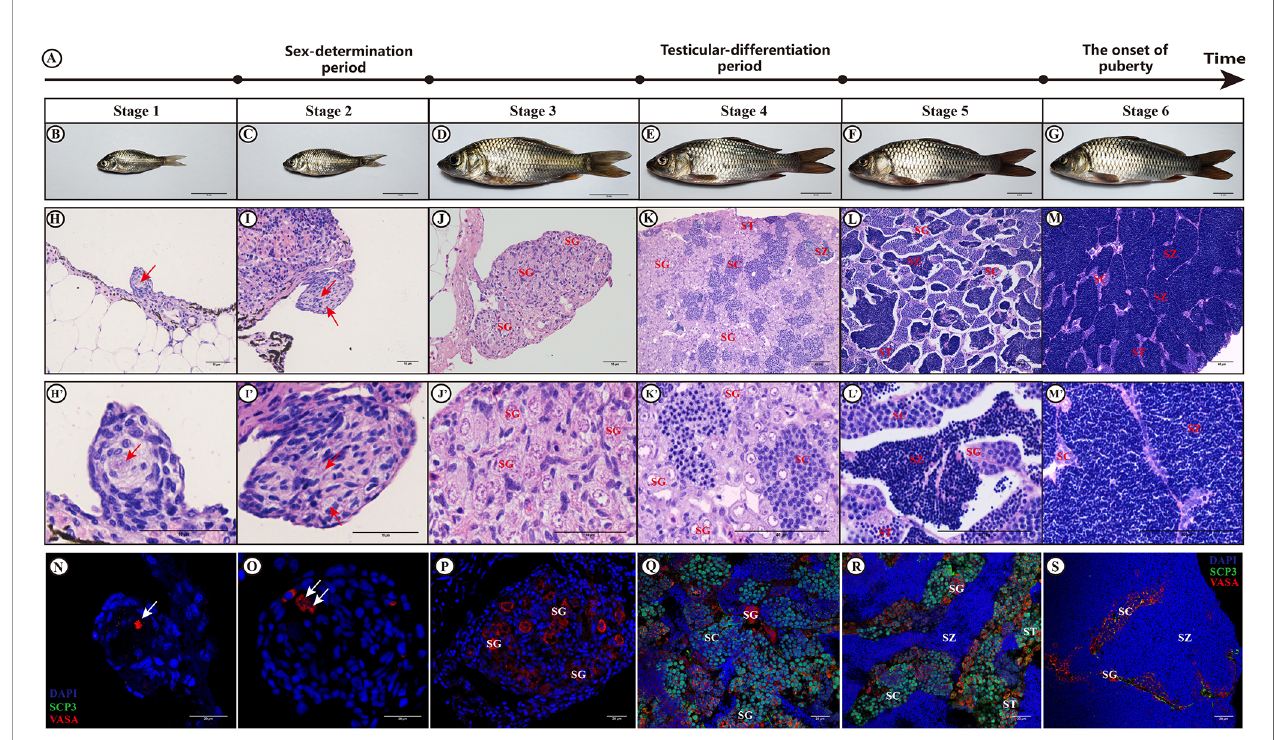
FIGURE 1 | Histology and immuno fl uorescent analysis. Observation of the gonads of XY male common carp at different developmental stages by H&E staining and immuno fl uorescence. (A) show the diagram illustrating the important biological events that occurred at six different testis developmental stages; (B – G) represent the gross morphology of fi sh samples at stages 1-6; (H – M) represent H&E staining results for the gonad at stages 1-6; (N – S) refer to the immuno fl uorescence results after staining with anti-VASA and anti-SCP3 antibodies at stages 1-6; Arrows, PGC; SG, spermatogonia; SC, spermatocytes; ST, spermatids; SZ, spermatozoa; Bar in (B – G) , (H – J) and (H' – J') , (K – M) and (K' – M') , and (N – S) represent 2 cm, 10 µm, 40 µm, and 20 µm, respectively. The sections incubated without primary antibodies did not show any immunostaining (not